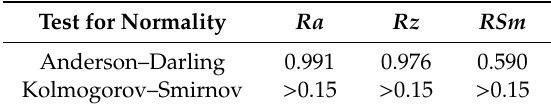
Table 4. The p -values of tests for normality of Ra , Rz and RSm